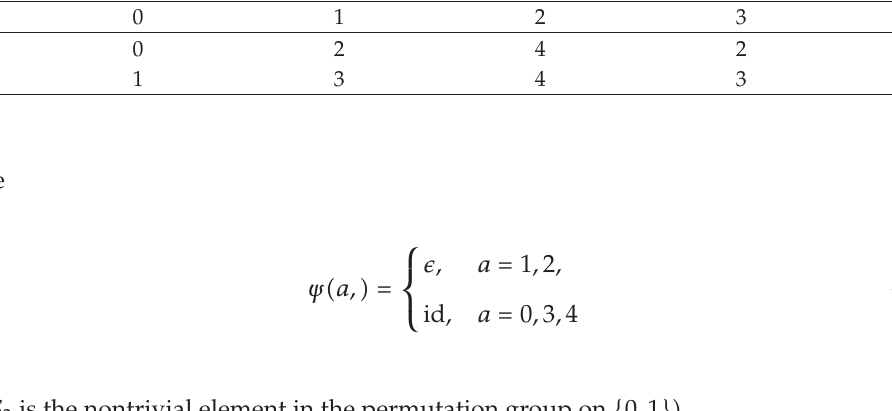
Table 1: Values of φ